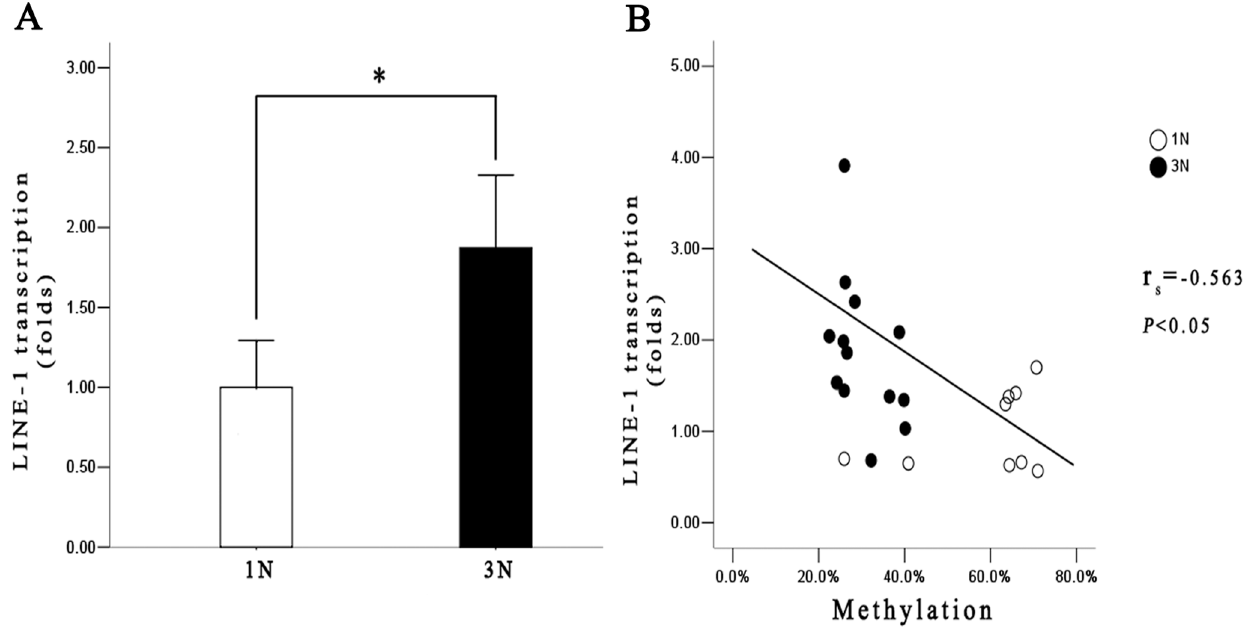
Figure 5. LINE-1 mRNA levels in first trimester (1N) and third trimester (3N) placentas and their correlation with methylation. A . Average LINE-1 mRNA levels were 1.9 folds higher in 3N placentas compared to 1N placentas ( P , 0.05). B . Inverse correlation of LINE-1 mRNA levels with methylation levels in 1N and 3N placentas (Spearman correlation, r s = 2 0.563, P , 0.05)